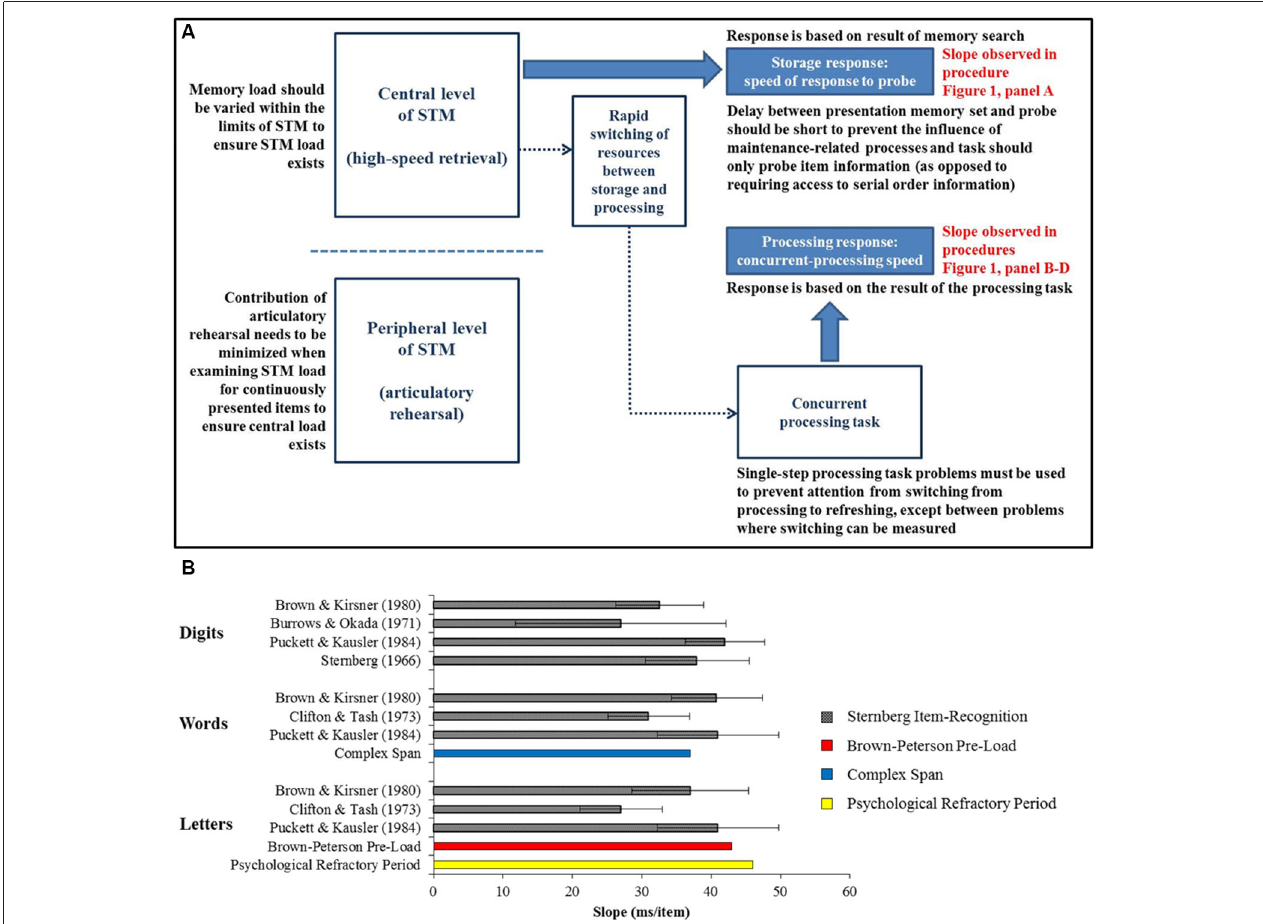
based on (1) the Sternberg Item-Recognition paradigm (gray bars), (2) the Brown-Peterson Pre-Load paradigm (red bar, second from the bottom), (3) the Complex Span paradigm (blue bar, last in the Words cluster), and (4) the Psychological Refractory Period (yellow bar, bottom). For the Sternberg Item-Recognition paradigm, the figure only includes studies that provided the information necessary to calculate 95% confidence intervals (represented by error bars). For the other paradigms, the unweighted average across studies mentioned in the text is